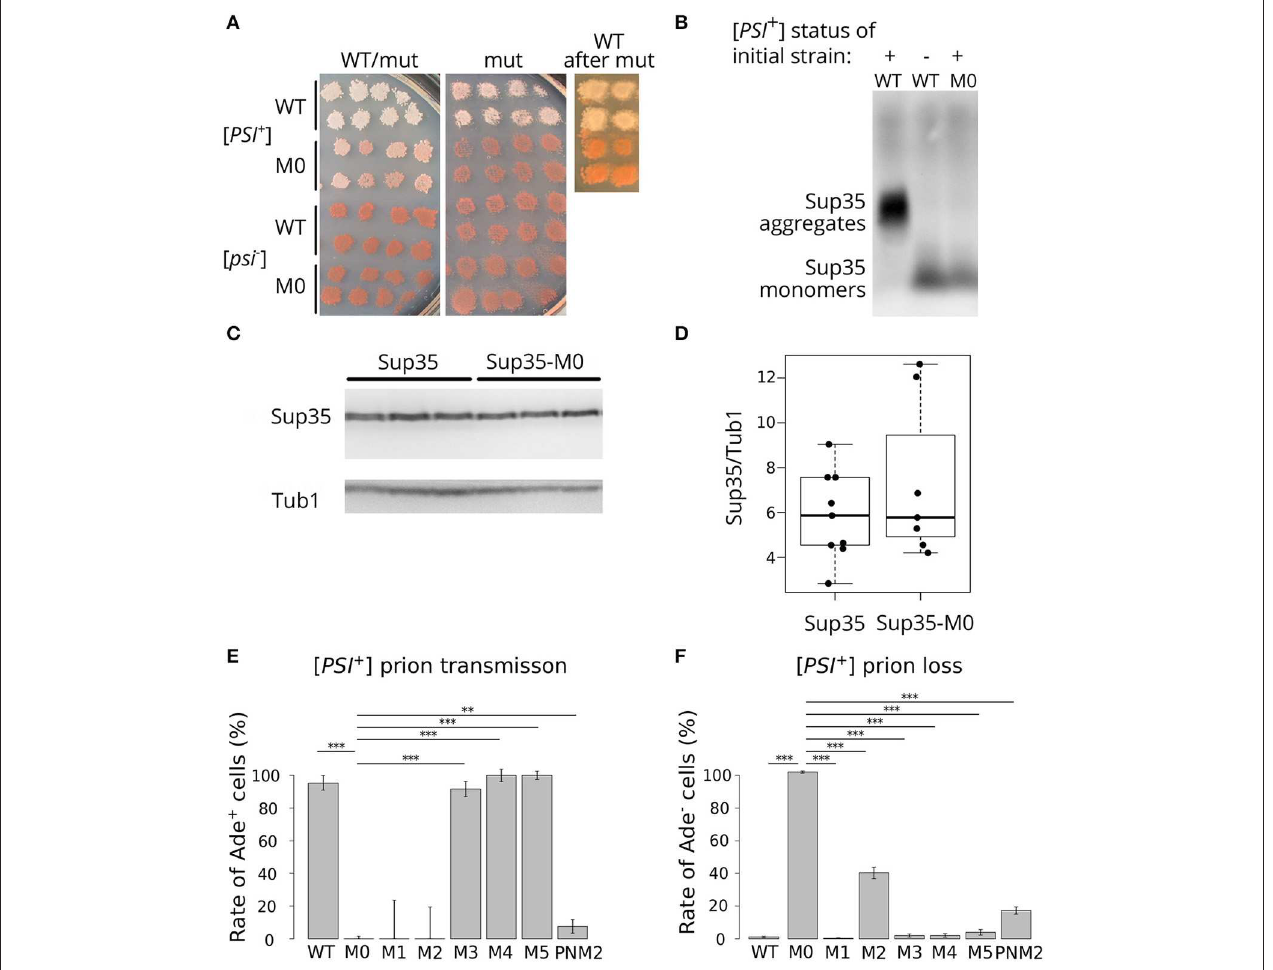
FIGURE 2 | sup35-M0 efficiently and irreversibly eliminates [ PSI + ] prion. (A) The phenotype of strains with different combinations of SUP35 and sup35-M0 alleles in [ PSI + ] and [ psi – ] strains on 1/4 YEPD is shown (images were taken after 4 days of incubation). Transformants bearing two plasmids with two wild-type alleles or combination of sup35-M0 and SUP35 are presented on the panel “WT/mut” (at least 16 transformants were analyzed). The phenotype of cells after the plasmid loss is shown on panel “mut”. Finally, sup35-M0 (or SUP35 as a control) were replaced with SUP35 by the reverse plasmid shuffling, phenotype of obtained strains is presented on panel “WT after mut.” (B) The sup35-M0 allele leads to the elimination of Sup35 aggregates according to SDD-AGE results. Antibodies against Sup35 were used for Western Blotting. (C) Result of Western Blot hybridization after SDS-PAGE analysis of protein lysates from the [ psi – ] strain with mutant or wild-type allele of SUP35 with anti-Sup35 and anti-Tub1 antibodies. (D) The densitometry analysis of Sup35 protein level (ten replicates) revealed no difference in Sup35 protein level in strains with sup35-M0 compared to SUP35 . (E) [ PSI + ] transmission from the wild-type to the indicated sup35 allele. Fraction of cells that retained the prion after loss of the wild-type allele is shown on graph. (F) [ PSI + ] loss induced by transient expression of the sup35 KK alleles and PNM2 mutation. Fraction of cells that have lost the prion after the loss of sup35 KK allele is shown. ** p -value < 0.01 and *** p -value < 0.001 according to Fisher’s exact